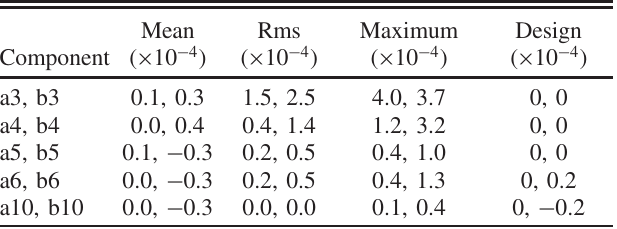
TABLE III. Magnetic measurement results for the DDBA quadrupoles (170 A).